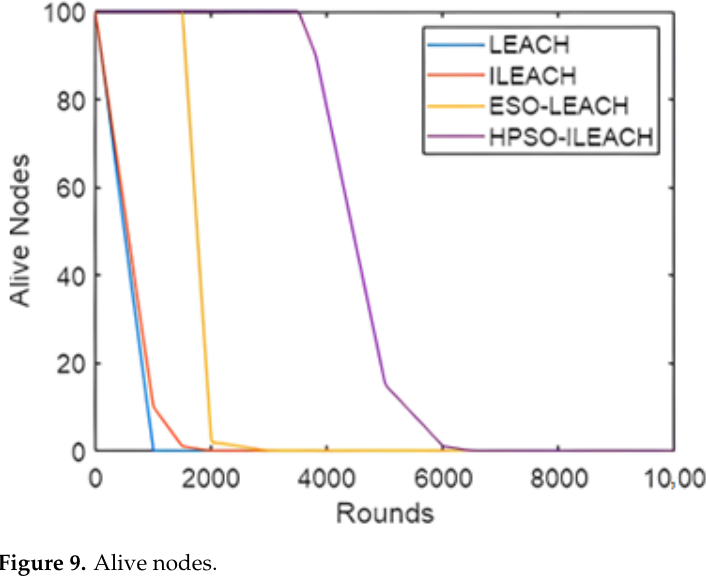
Figure 9. Alive nodes.